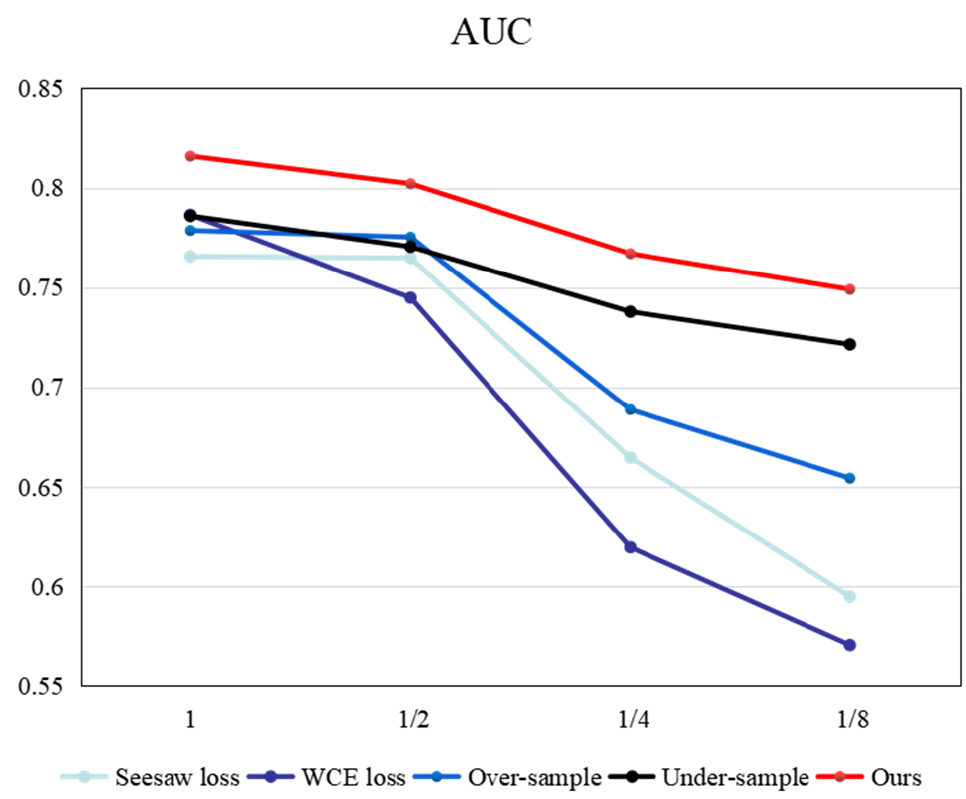
Figure 5. The AUC scores under different imbalance ratios.